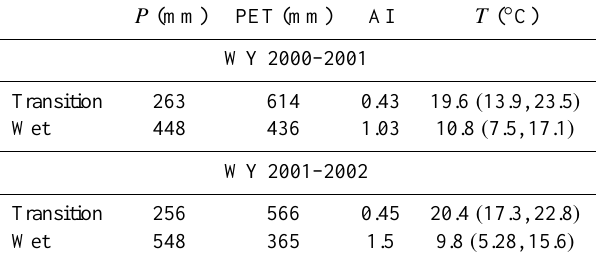
Table 1. Cumulative precipitation ( P ) and potential evapotranspi- ration (PET), aridity index (AI), and average air temperature ( T ) for the transition and wet periods during the study period at the Fuirosos Stream Watershed. The range of monthly temperature for each period is shown in